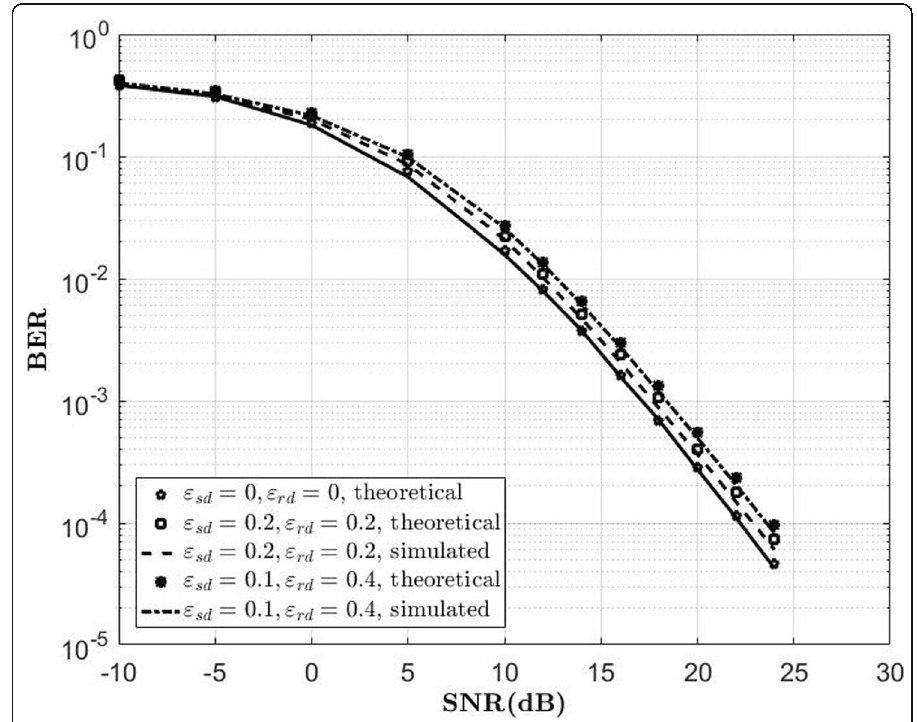
Fig. 5 Comparison of theoretical BER lower bound and the BER performance obtained from the